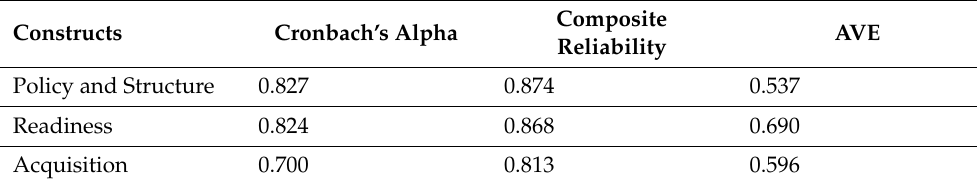
Table 4. The result of convergent validity.